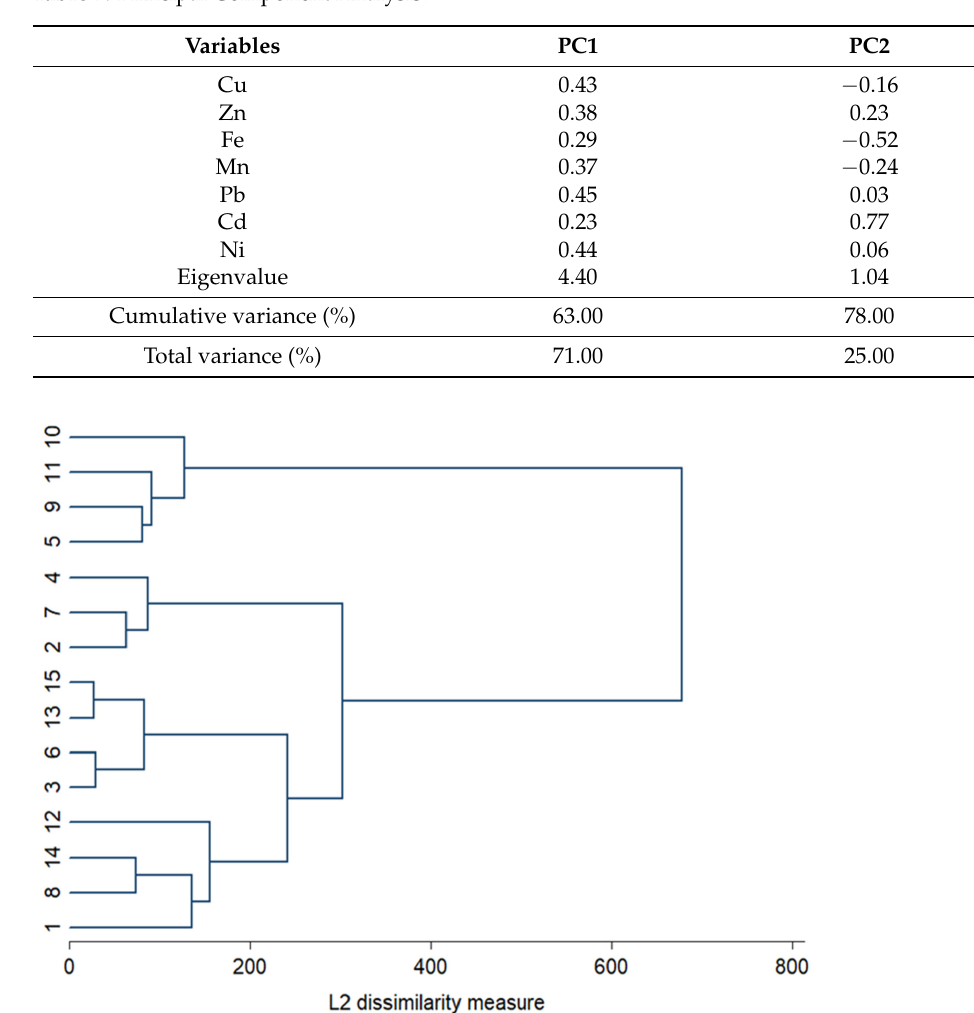
Figure 9. Cluster